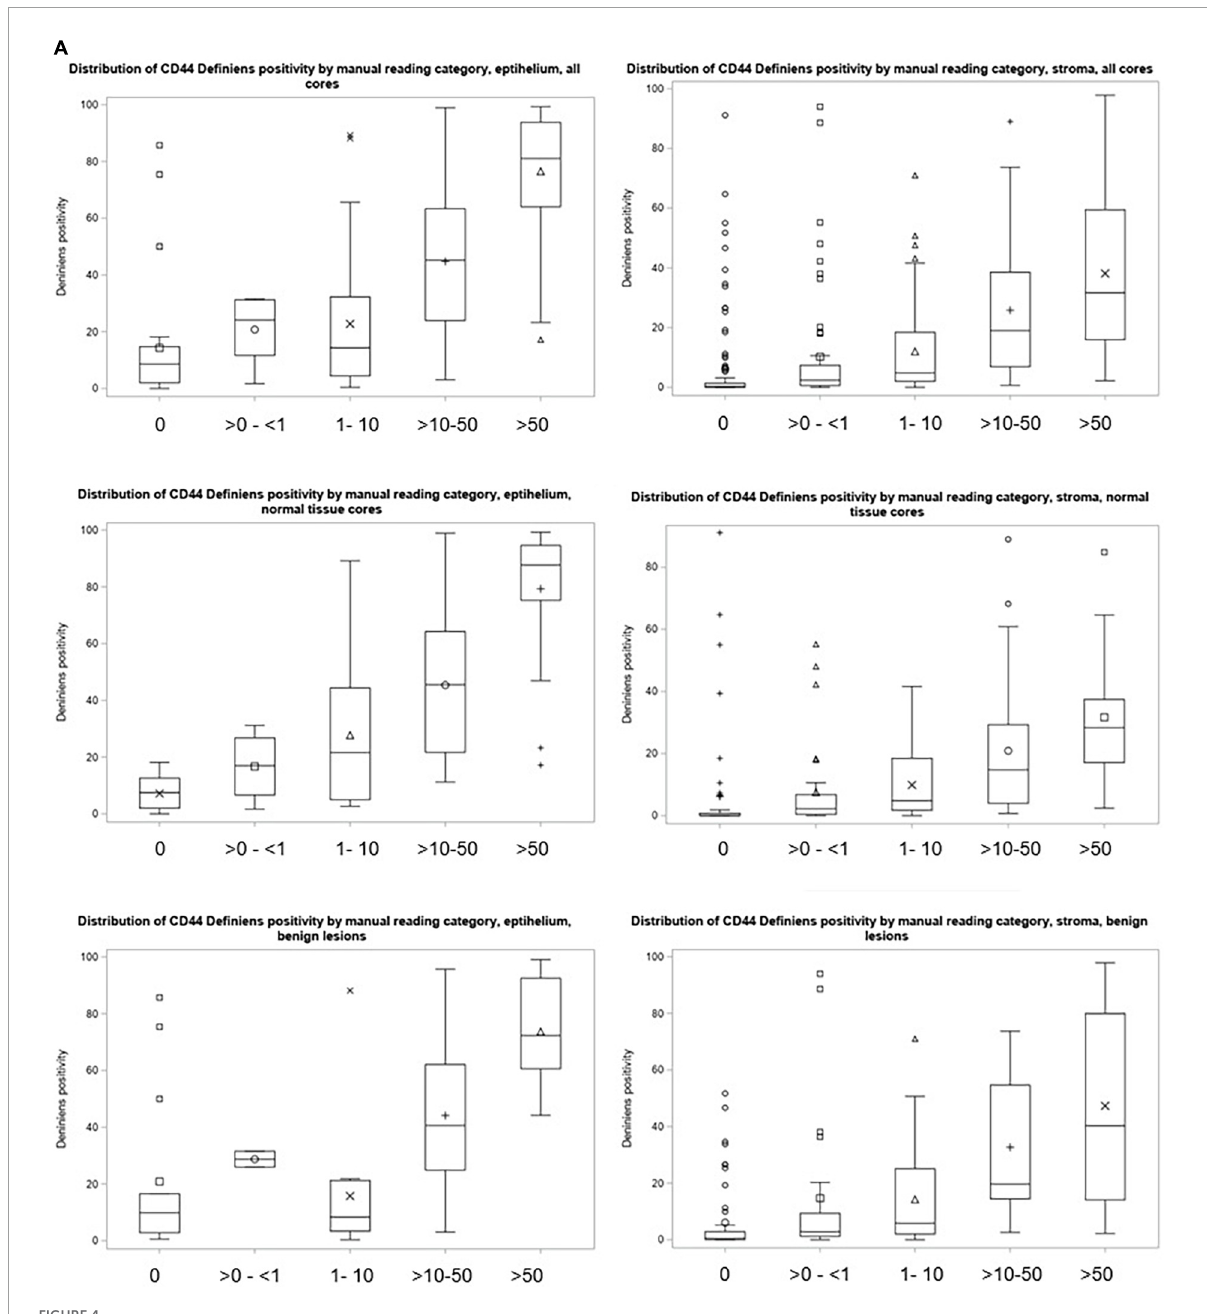
FIGURE4 (A) Distribution of CD44 Definiens positivity according to the manual reading